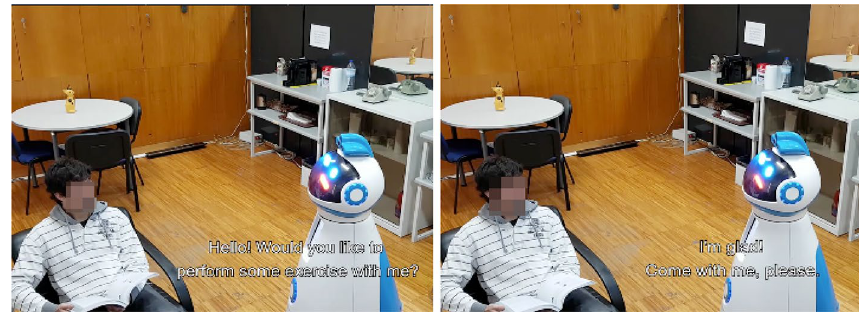
Fig. 6 Robotic buddy inviting user for some physical exercise